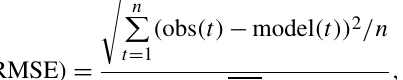
Figure 4. Atmospheric and snow observations at Halley between 27 March 2004 and 9 February 2005 from Jones et al. (2008). (a) Air temperature. (b) NO − in the surface snow (i.e. top 10 ± 15mm, orange square, left axis) and gas-phase HNO 3 (green, right axis). 3 where obs( t ) and model( t ) are the observed value and mod- elled value at time t , respectively, n is the number of obser- vations and obs is the observation